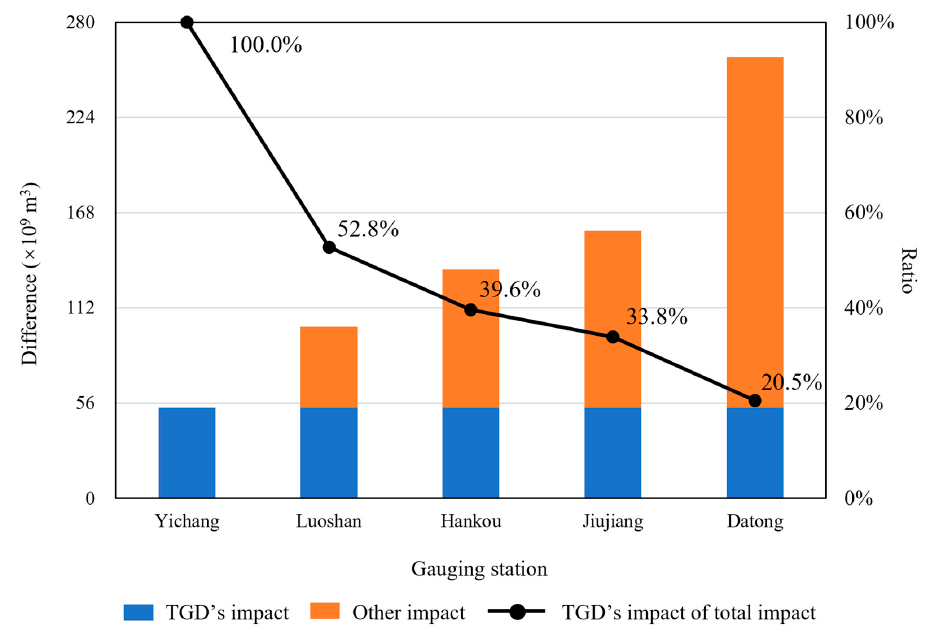
Figure 11. The TGD’s impact on five gauging stations based on an analysis of the maximum 30-day runoff. These results were calculated from the average of the difference between the observed maximum 30-day runoff and the reconstructed maximum 30-day runoff after the full operation of the TGD (see Table 5). The TGD’s impact on the Luoshan, Hankou, Jiujiang, and Datong gauging stations is equal to the TGD’s impact on the Yichang gauging station, assuming that the Yichang gauging station is completely controlled by the TGD.